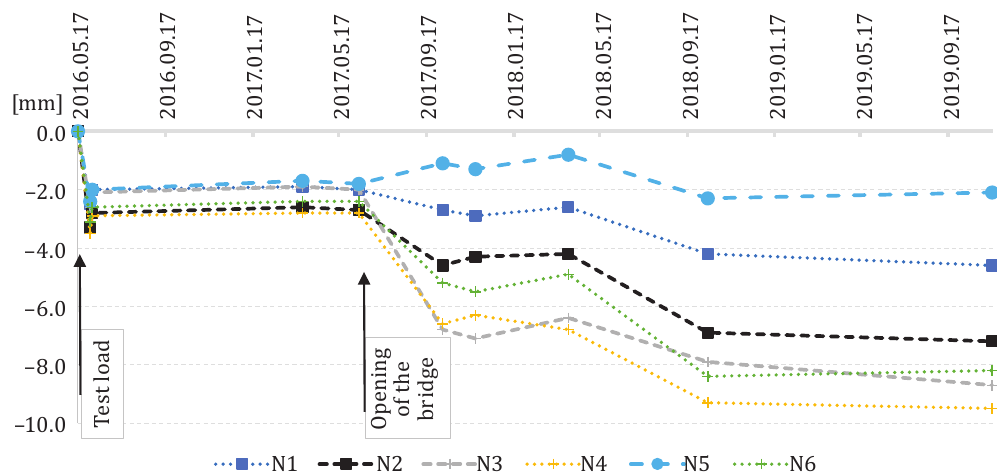
Figure 9. Vertical displacements (in mm) of control benchmarks N1–N6 within 3.5 years from starting test